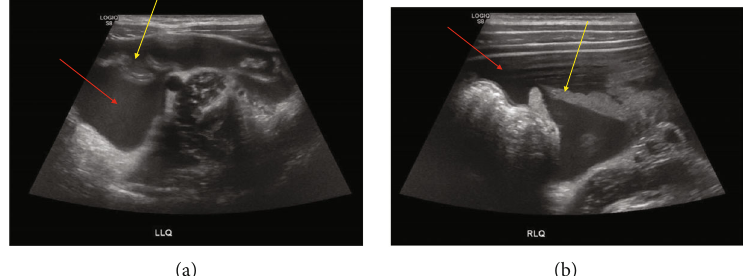
Figure 6: Ultrasound images of the left lower quadrant (a) and right lower quadrant (b) demonstrating ascites (red arrows) and omental thickening (yellow arrows).